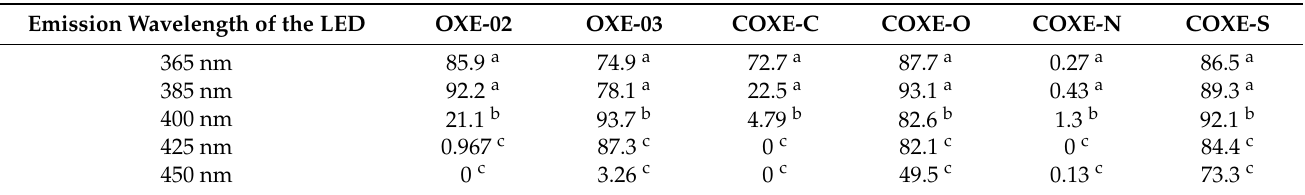
Table 3. C=C double bond conversion rate of TPGDA polymerization initiated by COXEs, OXE-02 and OXE-03 under LED light irradiation at different